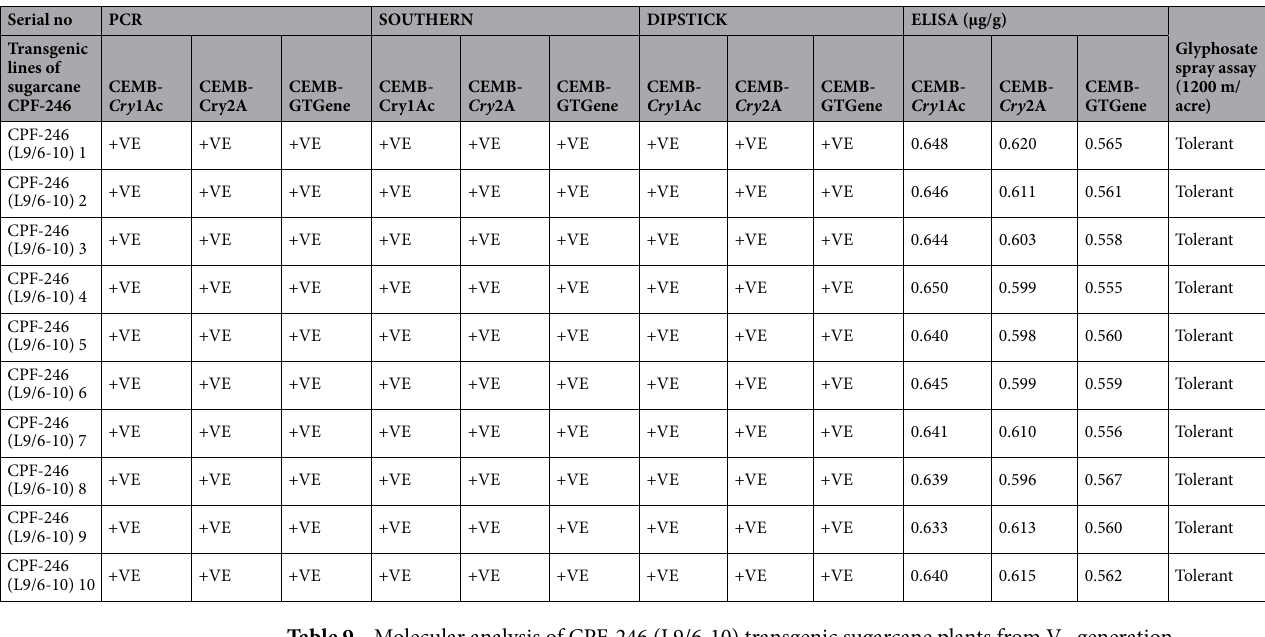
Table 9. Molecular analysis of CPF-246 (L9/6-10) transgenic sugarcane plants from V 2 -generation.